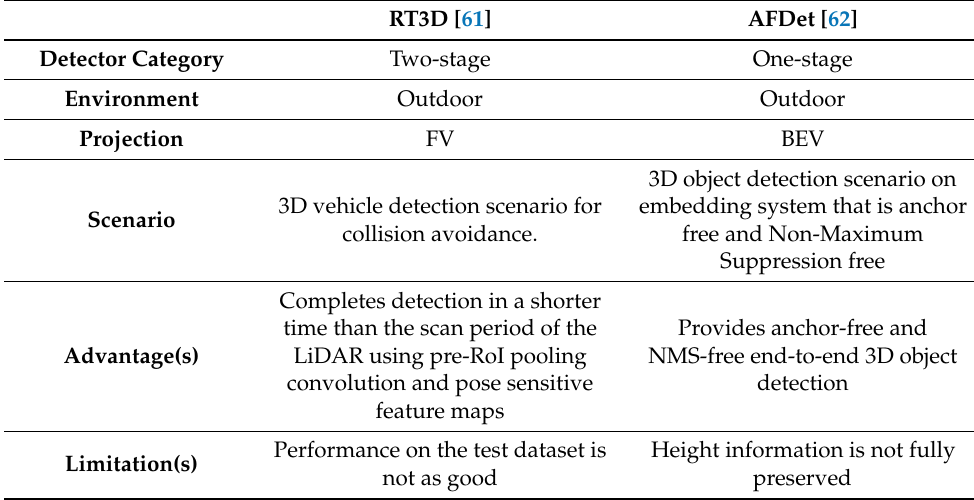
Figure 12. 3D detection pipeline of AFDet [62]. The numbers in square brackets represent output channels of the last convolution layer, and C indicates the number of categories. Table 11. Literature Analysis: 2D Image Grid-based 3DOR